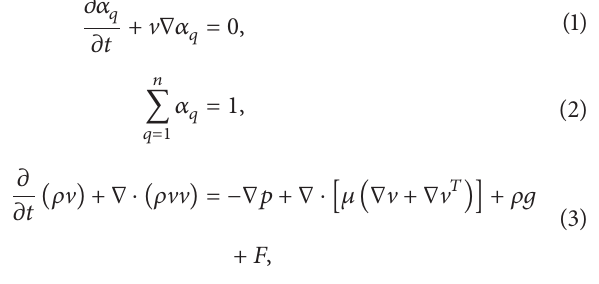
the geometric outer contour of the tire after rolling deforma- tion is created, and the rolling tire model is removed during the fluid calculation. Simulation results may vary by about 5%–10% with the computation domain size. The domain size with height 50 mm, length in front of tire 300 mm and behind 600 mm, and width 350 mm is considered from previous studies [17]. Figure 2 shows the computational domain, which is meshed by using multiblock grid